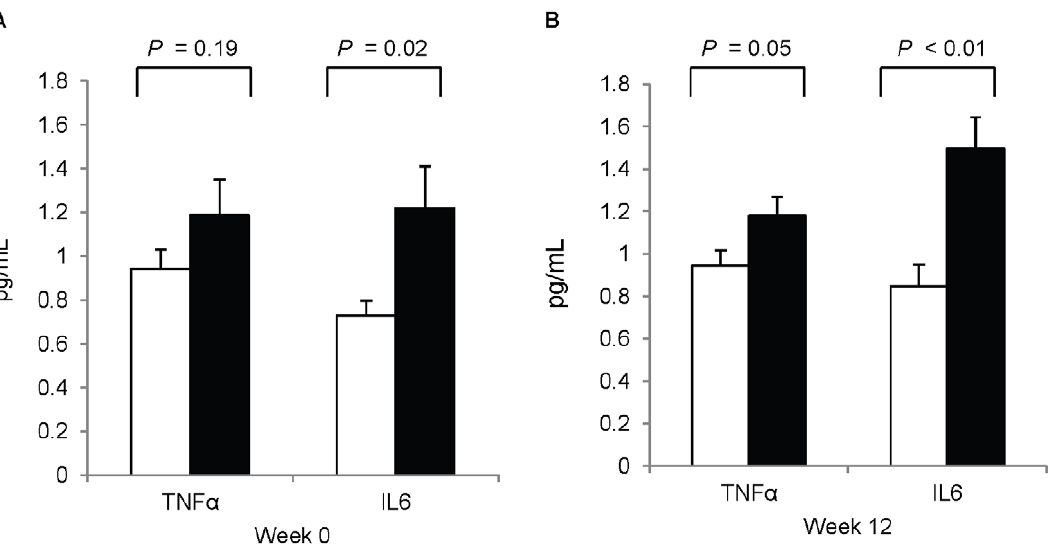
Figure 4. Plasma TNF a and IL6 concentrations. Plasma concentrations of TNF a and IL6 in third trimester pregnant versus nonpregnant women at study-baseline ( A ) and study-end ( B ). White bar: nonpregnant women (n=21); black bar: pregnant women (n=26). Values are means 6 SEM. Analyzed with general linear models.